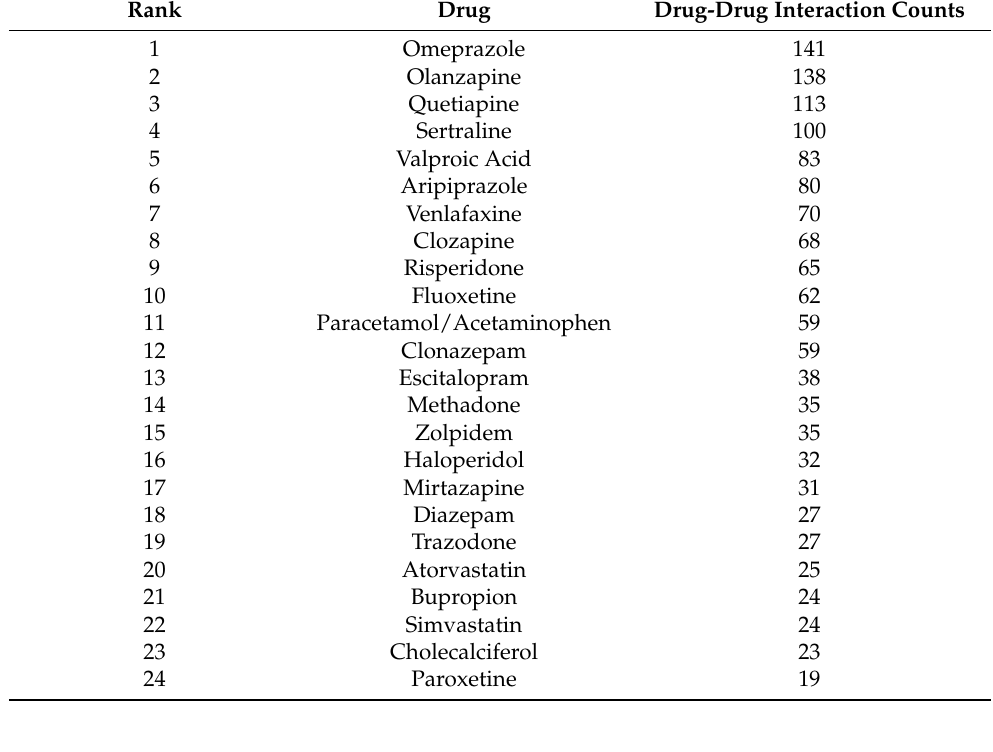
Table 3. Top 24 medications involved in potential drug–drug interactions in study population.